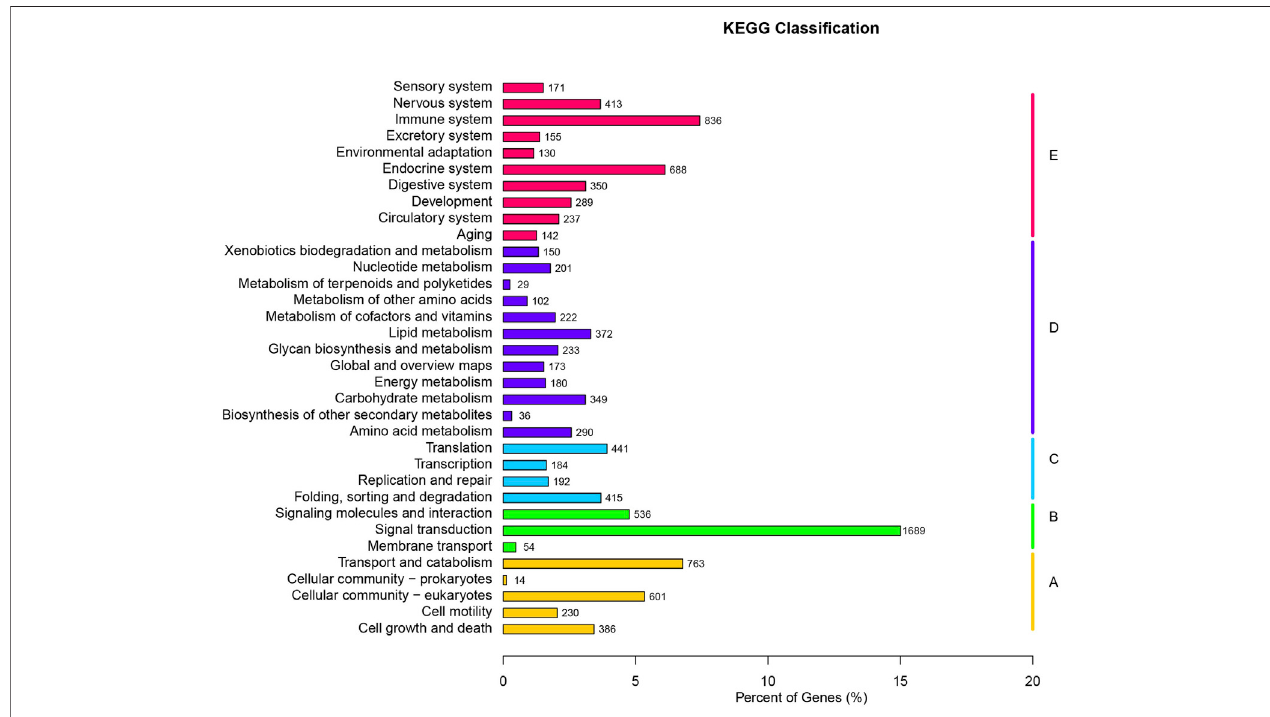
FIGURE 2 | KEGG classi fi cations of all unique sequences. (A) Cellular Processes; (B) Environmental Information Processing; (C) Genetic Information Processing; (D) Metabolism; (E) Organismal Systems.